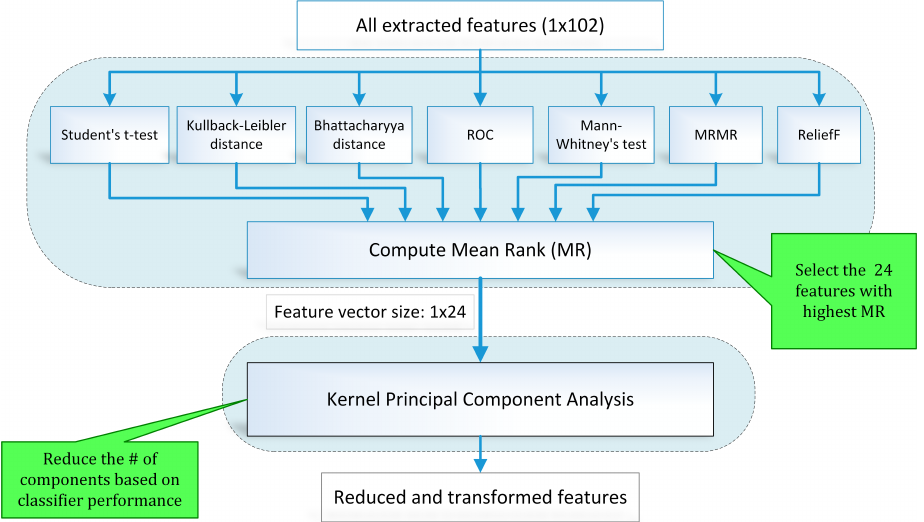
Figure 10. Block diagram (feature selection and reduction